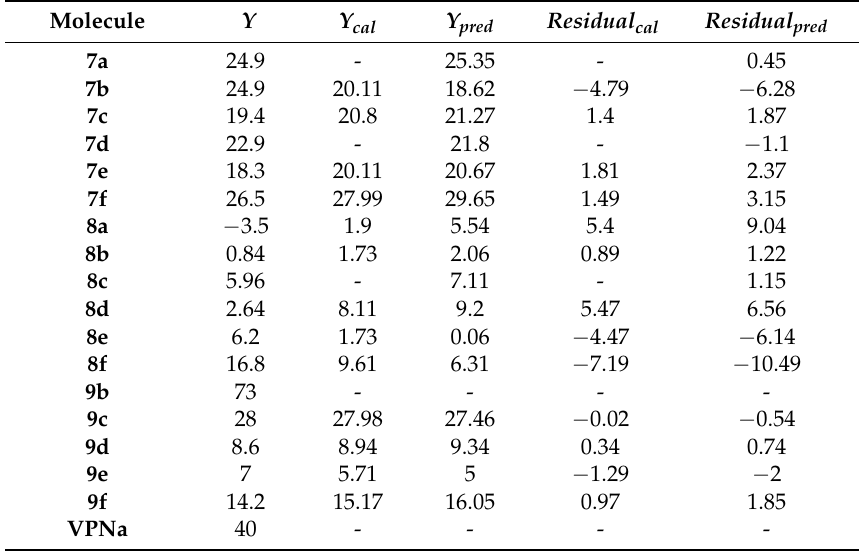
Table 7. Experimental GABA-AT inhibition % ( Y ), calculated ( Y cal ) and predicted ( Y pred ) for the GABA analogues in this study. The calculated and predicted residual values ( residual cal and residual pred ) are also